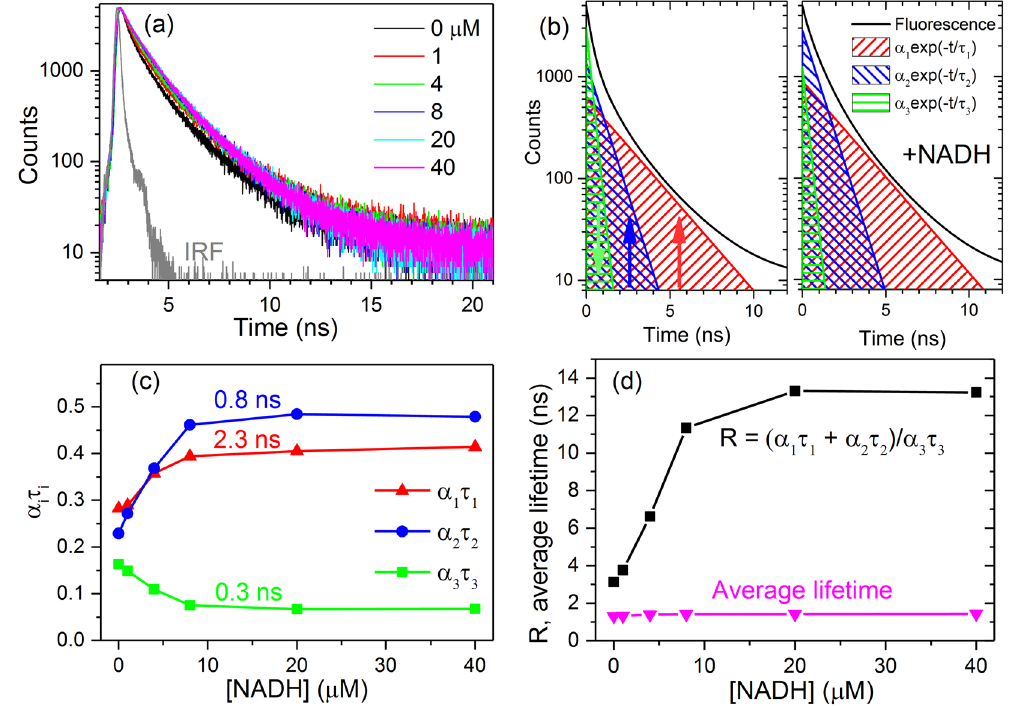
Figure 3. Time-resolved fluorescence of Frex in the NADH concentration titration experiment. ( a ) Time- resolved fluorescence decay curves of Frex (0.5 μ M) in the presence of various NADH concentrations. The fluorescence of Frex was excited at 488 nm and detected at 515 nm. Figure ( b ) shows the reconstructed tri- exponential and the corresponding mono-exponential decay curves of the time-resolved fluorescence decay profiles measured in the absence of NADH (left panel) and in the presence of 40 μ M NADH (right panel), respectively. ( c ) Fractional intensities ( α i τ i ) of Frex versus NADH concentrations. ( d ) Ratio of fractional intensities ( α τ α τ α τ = + R ( )/ ) and average lifetime of Frex versus NADH 1 1 2 2 3 3